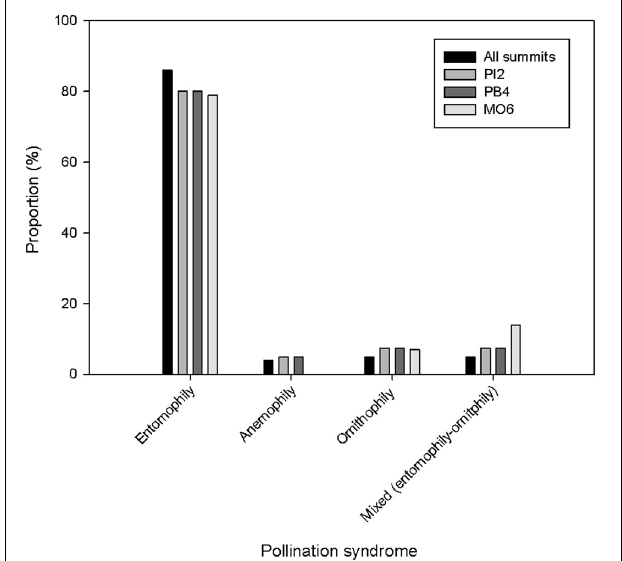
FIGURE 1 | Proportion (%) of plant species that belong to each pollination syndrome in the three summits (PI2, PB4, and MO6) of the GLORIA–Andes network (VE-CPB site), at La Culata National Park, Piedras Blancas Páramo, Venezuela.